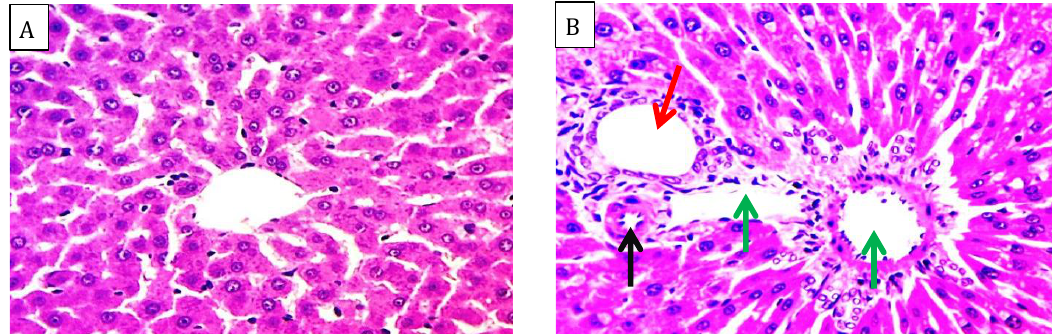
Figure 1 . Liver sections of control negative rats (Group 1, fed on a standard rat diet) showing normal hepatolobular structures. A: Normal hepatocytes and Kupffer cells surrounding the central vein in the centrilobular area. B: Normal hepatocytes surrounding branches of the hepatic artery (black arrow), portal vein (green arrow) and bile duct (red arrow) in the portal area. Moderate infiltration of inflammatory cells around blood vessels at the portal area is observed. H&E,